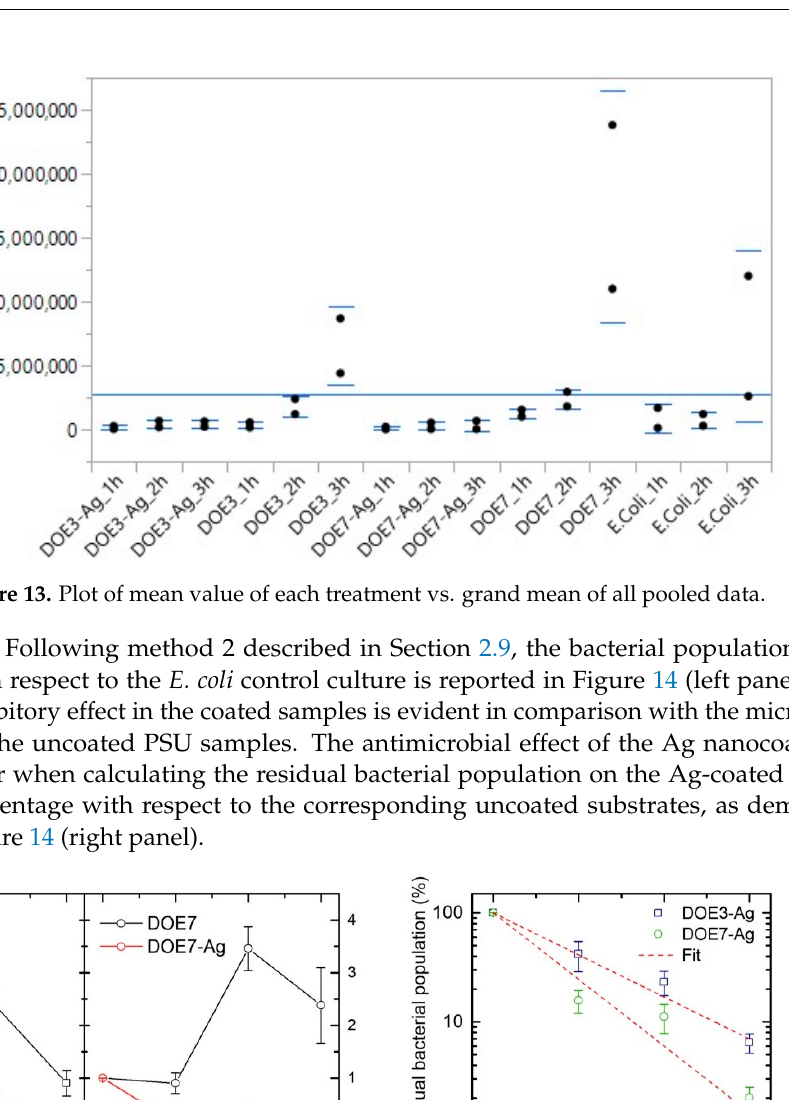
Figure 12. Matrix of Student t-values for mean-pair comparison.